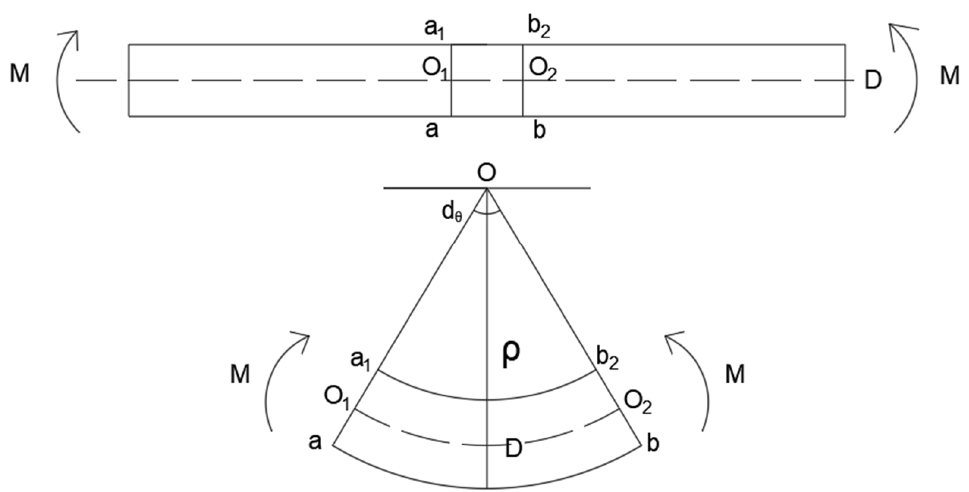
Figure 3. Schematic diagram of branch bending. M is the torque of the beam structure; O is the maximum deformation position of the beam structure; O 1 O 2 is micro-element segment on neutral axis; ab is the elongated edge of the micro-element segment; a 1 b 2 is the compressed edge of the micro-element segment; ρ is the curvature radius of neutral layer after deformation; D is the branch diameter.